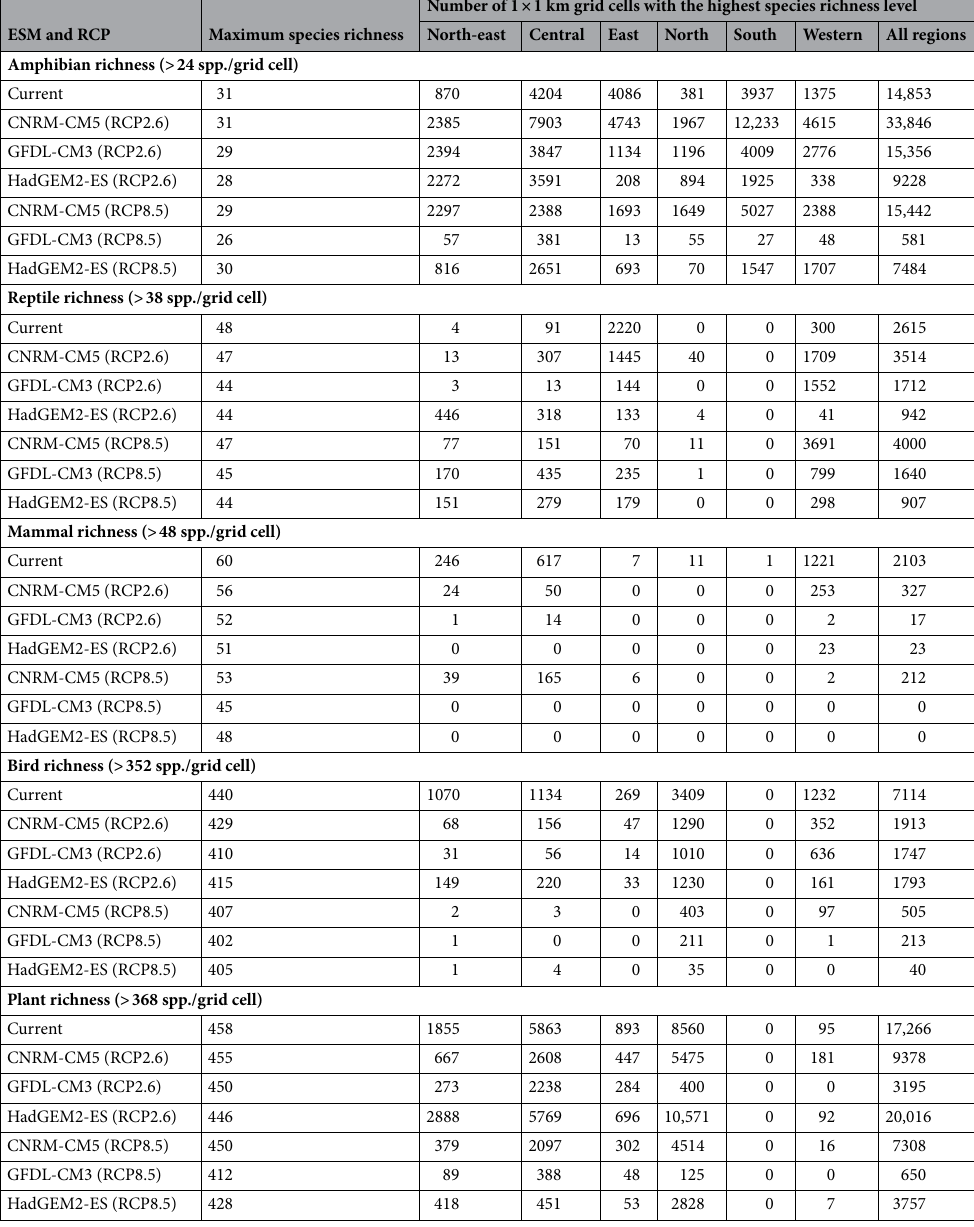
Table 2. Estimated maximum species richness (per km 2 ) and the total area with the highest richness level for each region of Thailand for the present and projected for 2070, using three earth system models and two